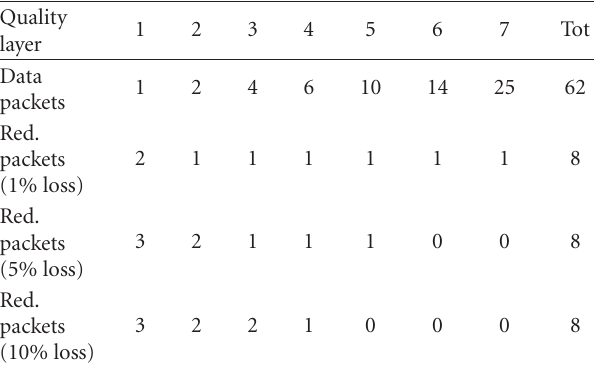
Table 2: Redundancy allocation for depth information ( R =